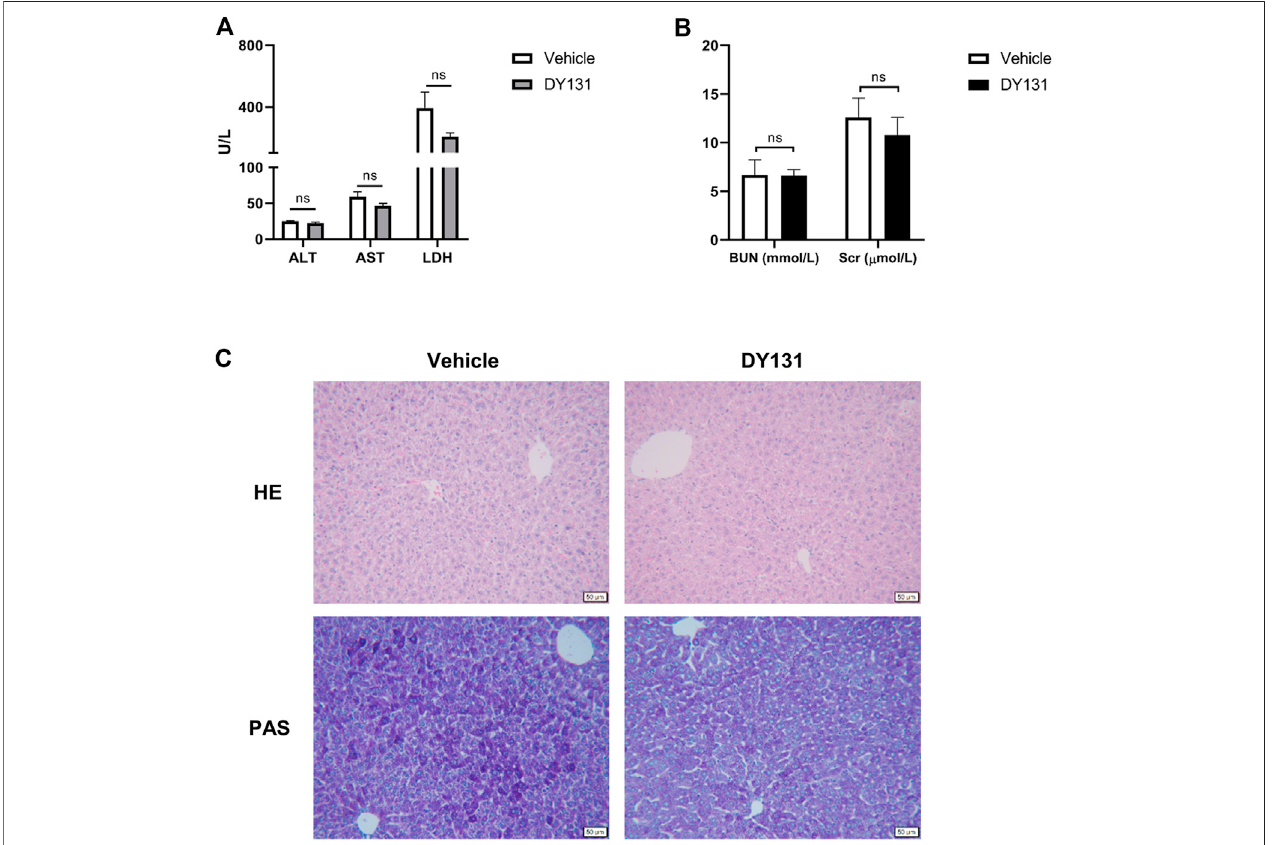
FIGURE6| EvaluationoftheinvivotoxicityofDY131atthedoseof5 mg/kg.AdultmaleC57BL/6 JmicewereintraperitoneallyadministeredwithDY131(5 mg/kg/ day, dissolved in 200 μ L saline) or 200 μ L saline (vehicle) for three days. (A,B) Serum levels ofALT, AST, LDH, Cr and BUN (n (cid:1) 5 in each group). (C) Liver sections were stained with H&E and PAS (magni fi cation × 200, scale bar: 50 μ m). Data were presented as means ± SEM. NS, no signi fi cance.